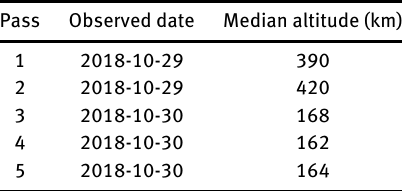
Table 6. Observations information of